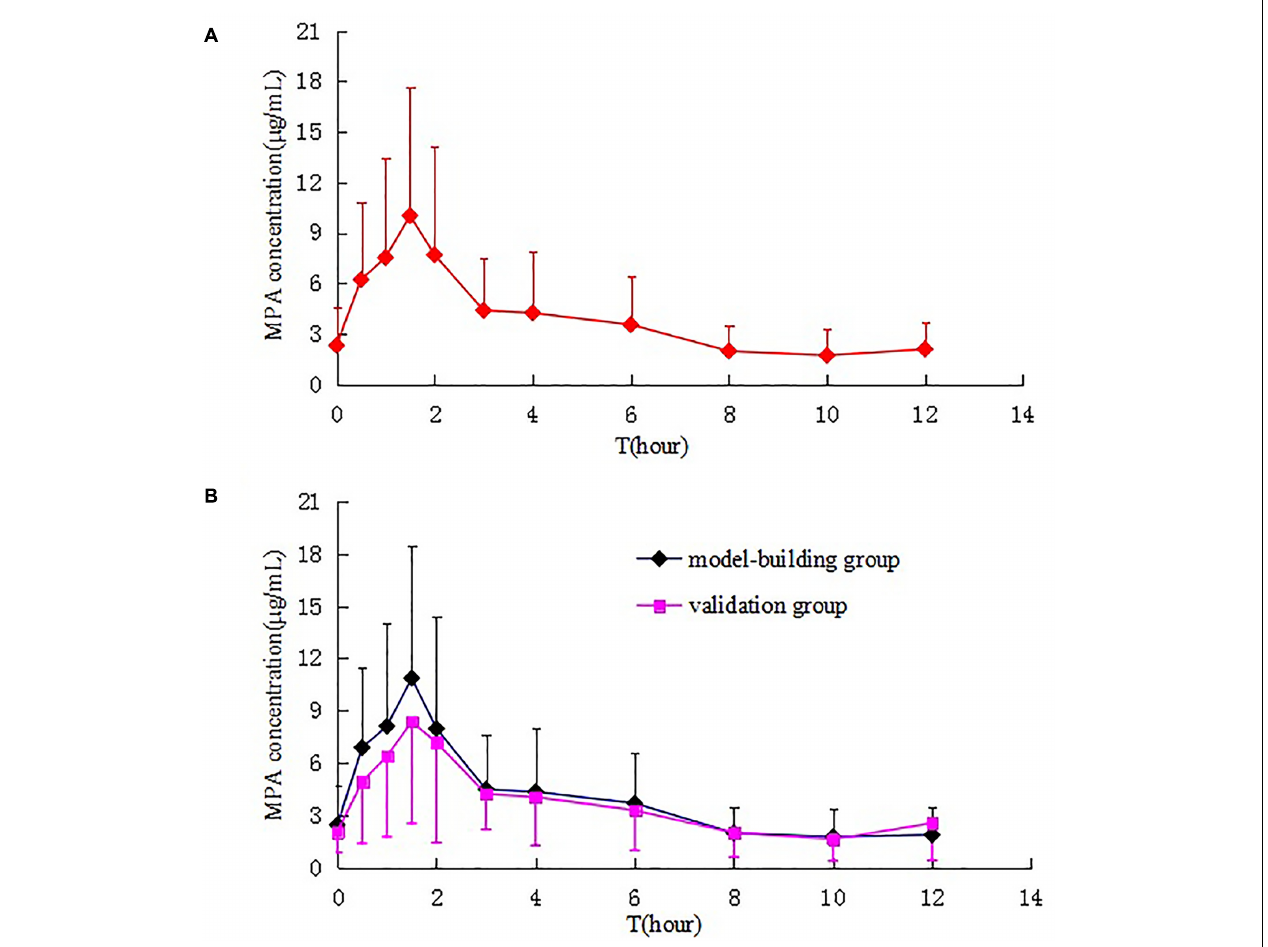
FIGURE 2 | Mean plasma concentration–time curves of MPA after administration of MMF dispersible tablets in all patients (A) , model-building group and validation group (B)